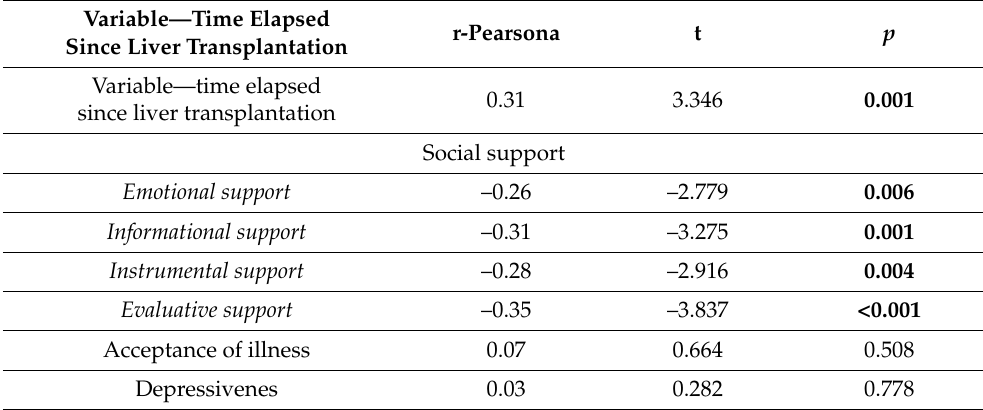
Table 8. The correlation between the time elapsed since liver transplantation and the levels of adherence to therapeutic recommendations, social support according to the ISSB, acceptance of disease according to the AIS, depression according to the BDI, and anxiety according to the